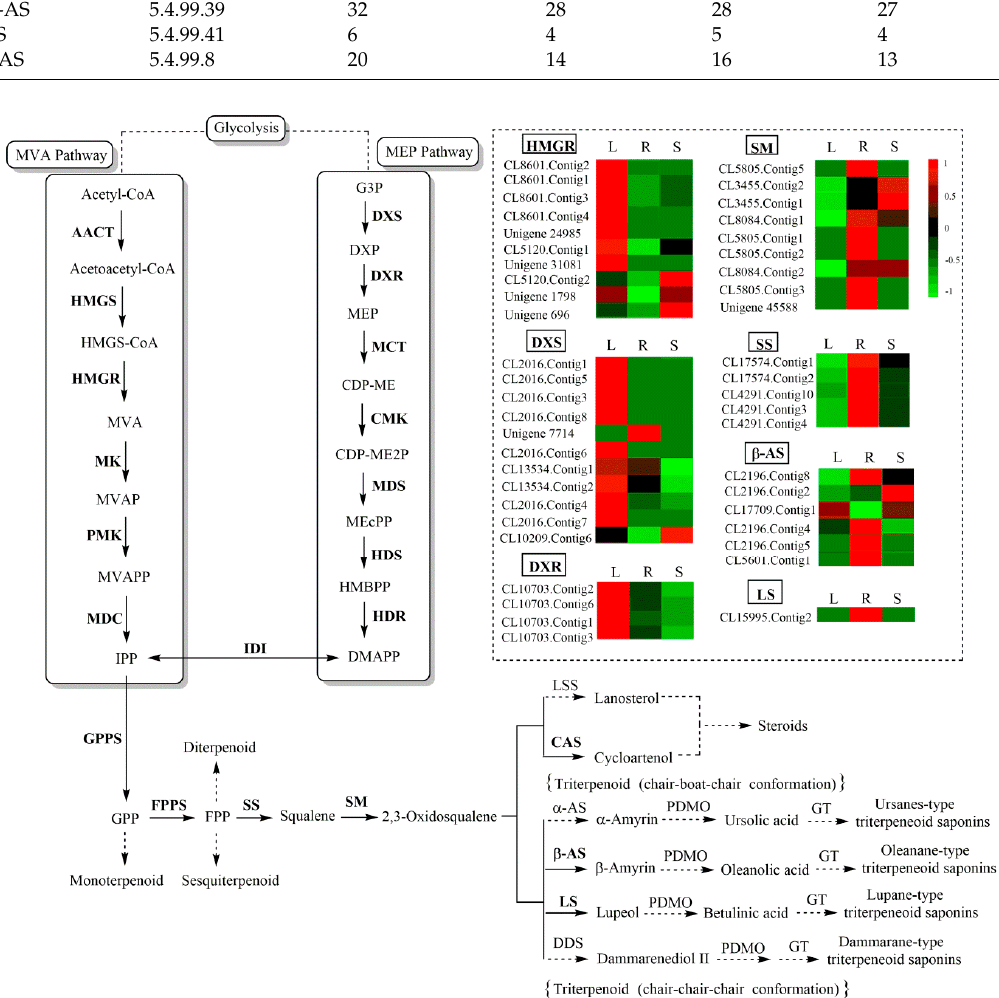
Figure 3. Pathway for triterpenoid saponin biosynthesis in C. chinense. The expression levels of unigenes encoding key enzymes from each process are shown using a heatmap. The columns L, R, and S correspond to leaf, root, and stem samples, respectively; red and green represent high and low expression levels, respectively. Table 2. Number of unigenes encoding the key enzymes involved in the biosynthesis of triterpenoid saponins in C. chinense.